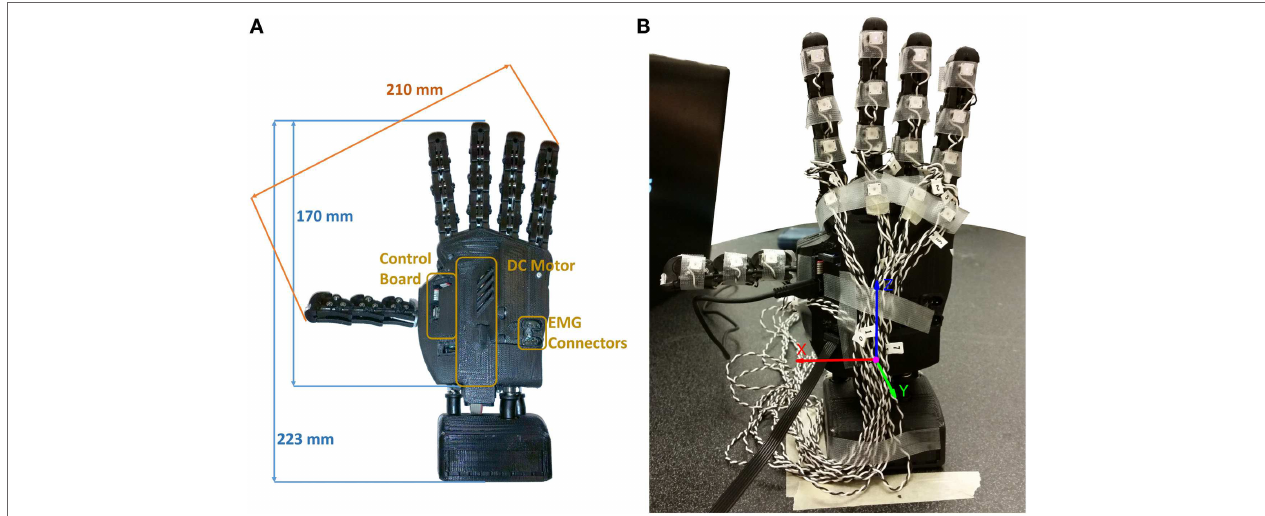
FIGURE 1 | SH-P used for Experiments 1 and 3 . (A) Dimensions of SH-P and the main components. (B) Markerization protocol (Experiment 1). Note that only the markers placed on the distal phalanges were used for the experiment, whereas additional markers in a triangular configuration were placed on the palm (not visible in this